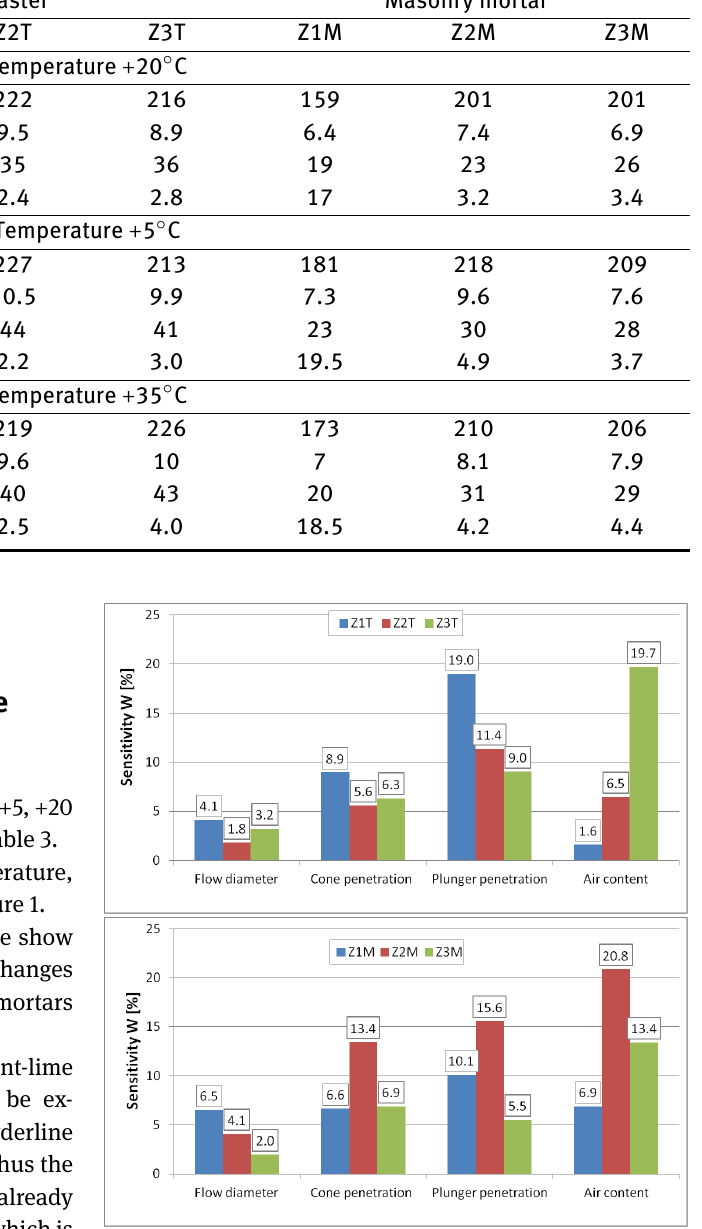
Table 3: Results of the tests for plaster and mortars in three temperatures: + 20 ∘ C, + 5 ∘ C, and + 30 ∘ C. (cid:96)(cid:96)(cid:96)(cid:96)(cid:96)(cid:96)(cid:96)(cid:96)(cid:96)(cid:96)(cid:96)(cid:96)(cid:96)(cid:96)